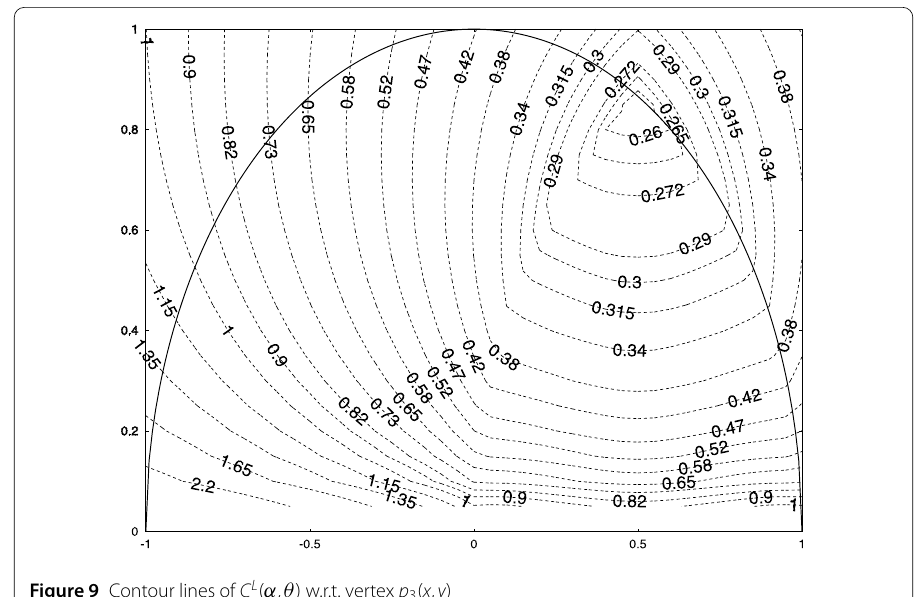
Figure 9 Contour lines of C L ( α , θ ) w.r.t. vertex p 3 ( x , y